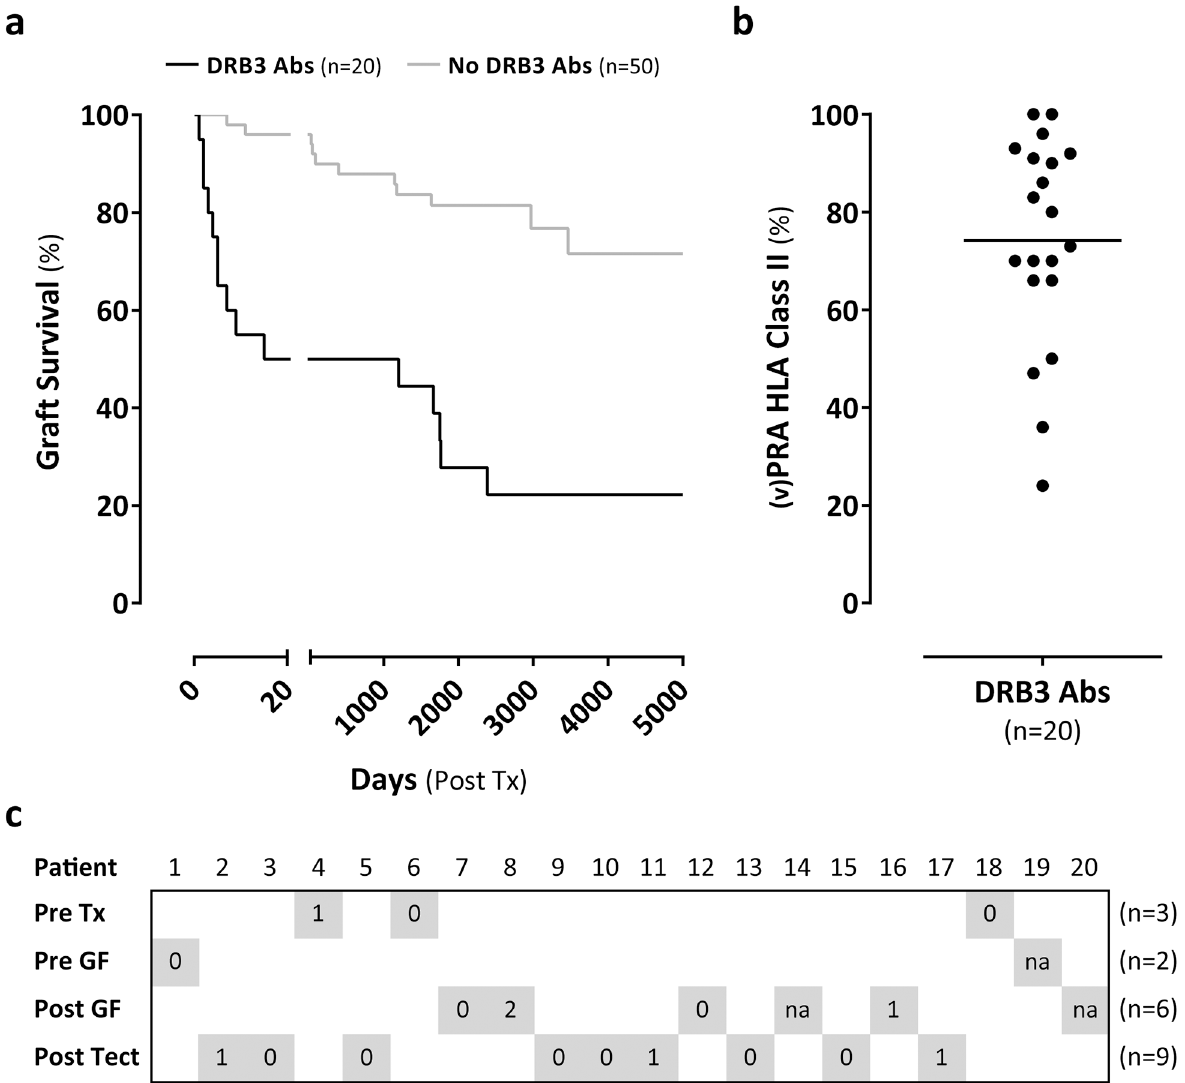
Fig 5. Graft survival in transplant recipients with or without HLA-DRB3 antibodies. a. Kaplan-Meier survival curve of transplanted grafts in recipients with ( n = 20) or without ( n = 50) HLA-DRB3 antibodies. The loss of a transplanted graft (survival) was defined as the date of graft failure after transplantation. Log-rank (Mantel-Cox) test with P < 0.0001. b. The (v)PRA HLA class II percentage of the recipients with HLA-DRB3 antibodies. The (v)PRA was determined in the same serum sample as the HLA-DRB3 antibodies. (v)PRA = (virtual) panel reactive antibodies. c. Overview panel indicating the moment when HLA-DRB3 antibodies were found in the 20 recipients with HLA-DRB3 antibodies. The light grey squares show whether the antibodies were found before transplantation (pre tx), before graft failure (pre GF), after graft failure (post GF), or after transplantectomy (post tect). Other detected donor specific antibodies are shown as a number or as not available (na) in the squares.